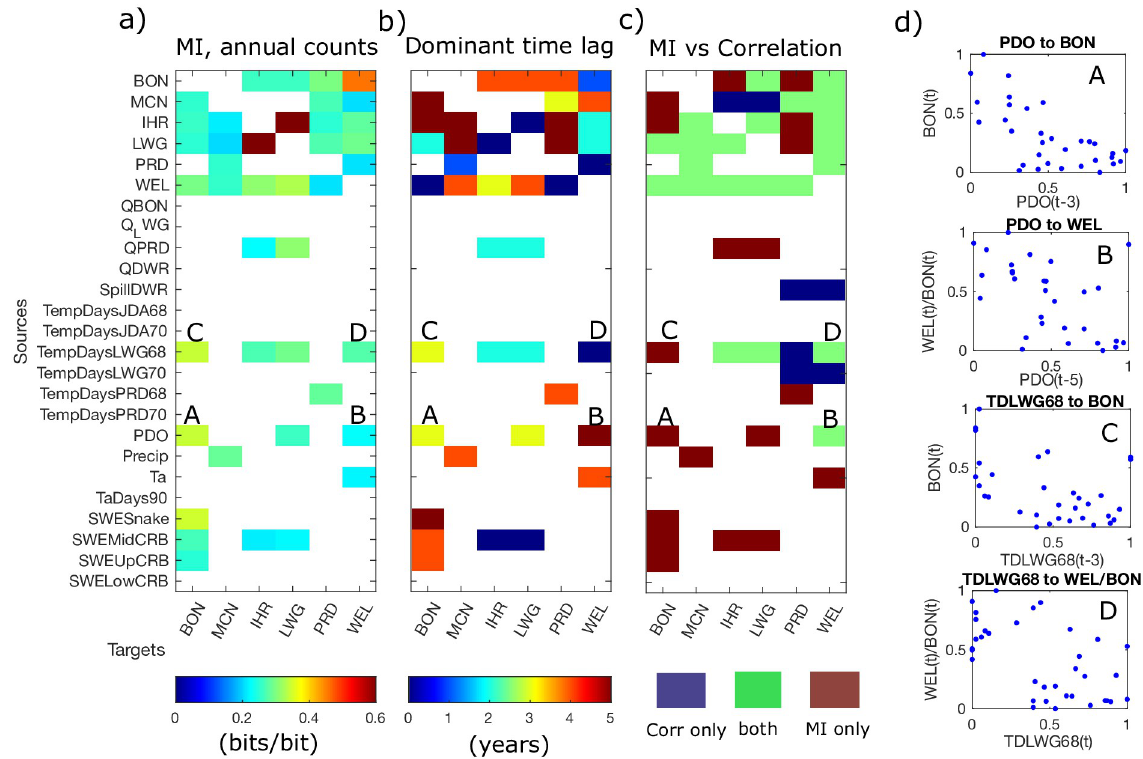
Fig 8. MI and dominant lags between indicator variables and annual total counts for 35-year windows, and comparison of statistically significant links based on MI versus linear correlation. (a) Mutual information divided by entropy of annual salmon counts. (b) Associated dominant time lags (years) for each MI measure. (c) Statistically significant ( p < 0.01) detections of MI , linear correlation, or both for each variable pair. White areas indicate pairs for which neither MI or correlations are detected. (d) Scatter plots of certain annual variables, normalized to a 0-1 range, showing lagged relationships for selected source-target pairs labeled in (a-c) , illustrating both linear and non-linear dependencies captured as MI (B,D) or both linear correlations and MI (A,C).